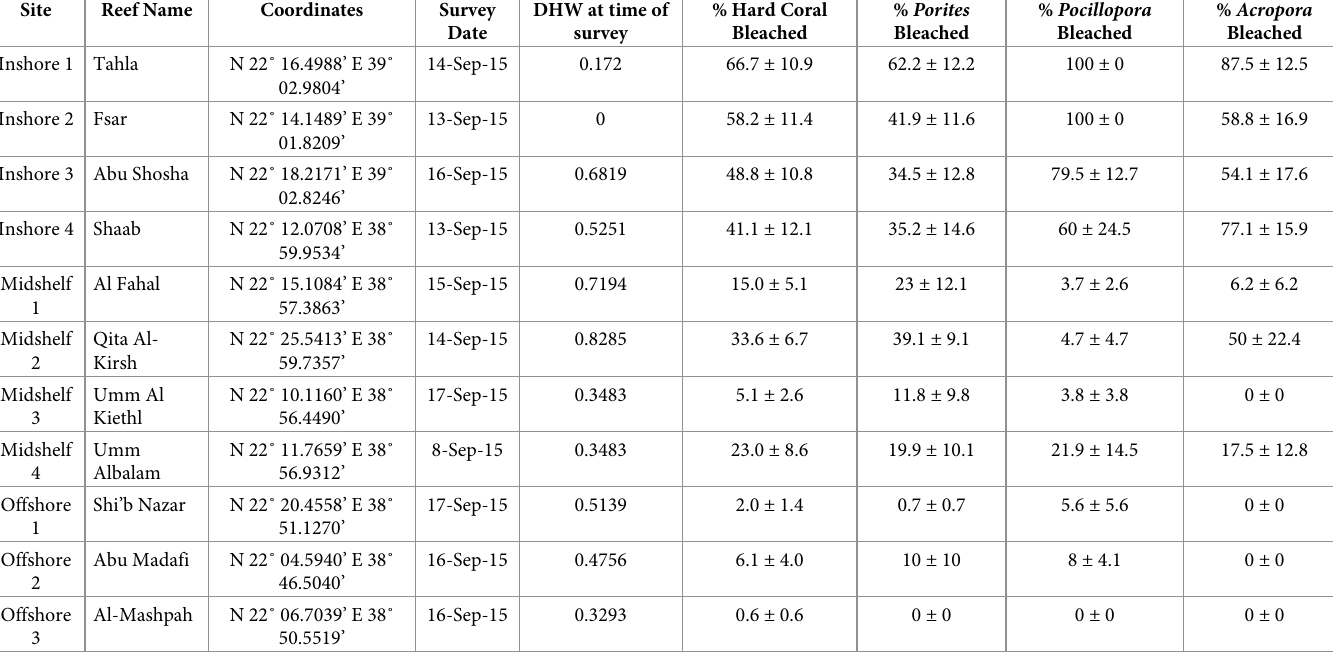
Percentages show mean proportions of cover for all hard corals and the most abundant genera that were bleached in 2015 (all depths combined). DHWs were downloaded using the reef coordinates from NOAAs CRW 5km daily product